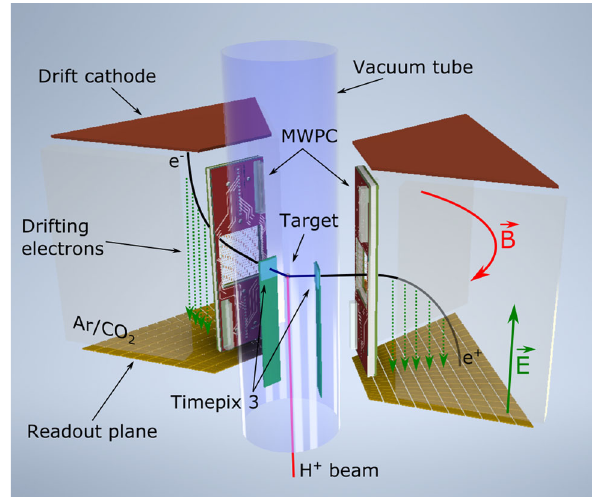
Fig. 10 A schematic view of the planned experiment where two out of six sectors are shown and the three layers of detectors are visible. See the text for